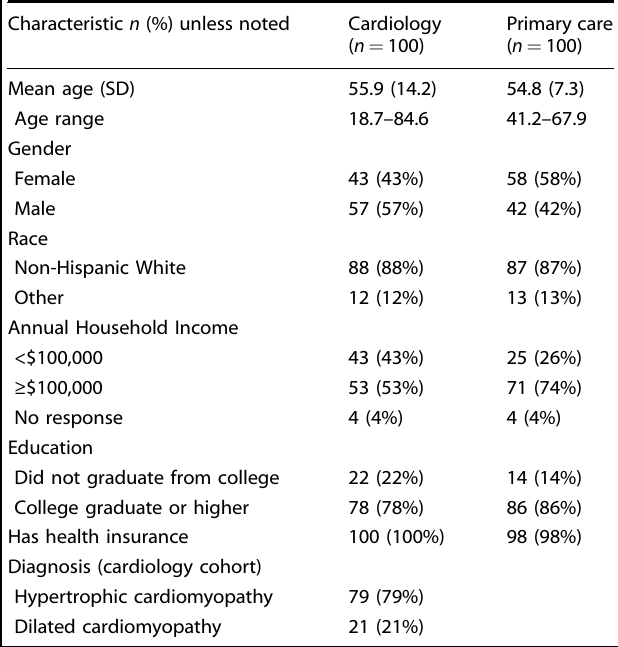
Table 1. Participant characteristics.